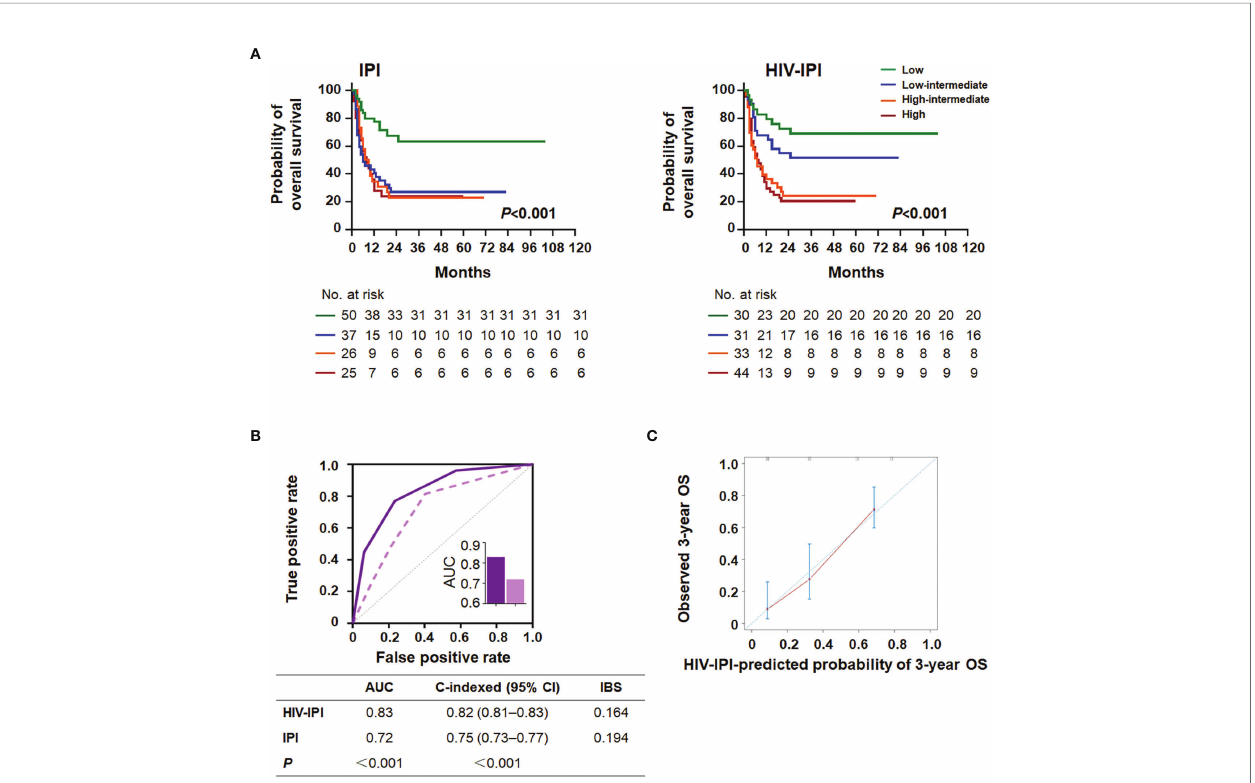
FIGURE 4 | HIV-IPI risk score to predict overall survival in AIDS-related lymphoma patients. (A) Kaplan – Meier survival curves and log-rank P -values of OS according to the IPI (left) and the HIV-IPI (right) prediction models in the AIDS-related lymphoma cohort. (B) The receiver operating characteristic (ROC) curves, area under the curves (AUC), C-indexes, and IBS of the IPI and the HIV-IPI prognostic systems for predicting overall survival. (C) Calibration curve of the HIV-IPI model for predicting 3-year overall survival ( n =